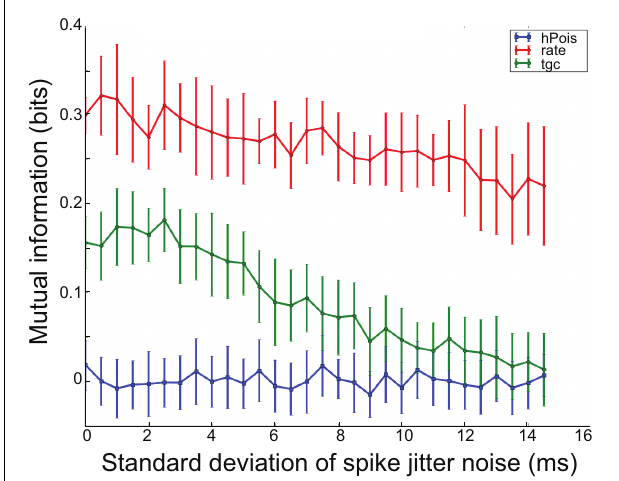
FIGURE 2 | Temporal precision of test systems. Decreases in mutual information with increases in spike jitter indicate that information is lost when spike times are perturbed. Thus, a relatively constant function indicates little sensitivity to spike times such as with the rate code, whereas the rapidly decreasing function for the tgc system indicates high sensitivity to spike times, and hence a timing